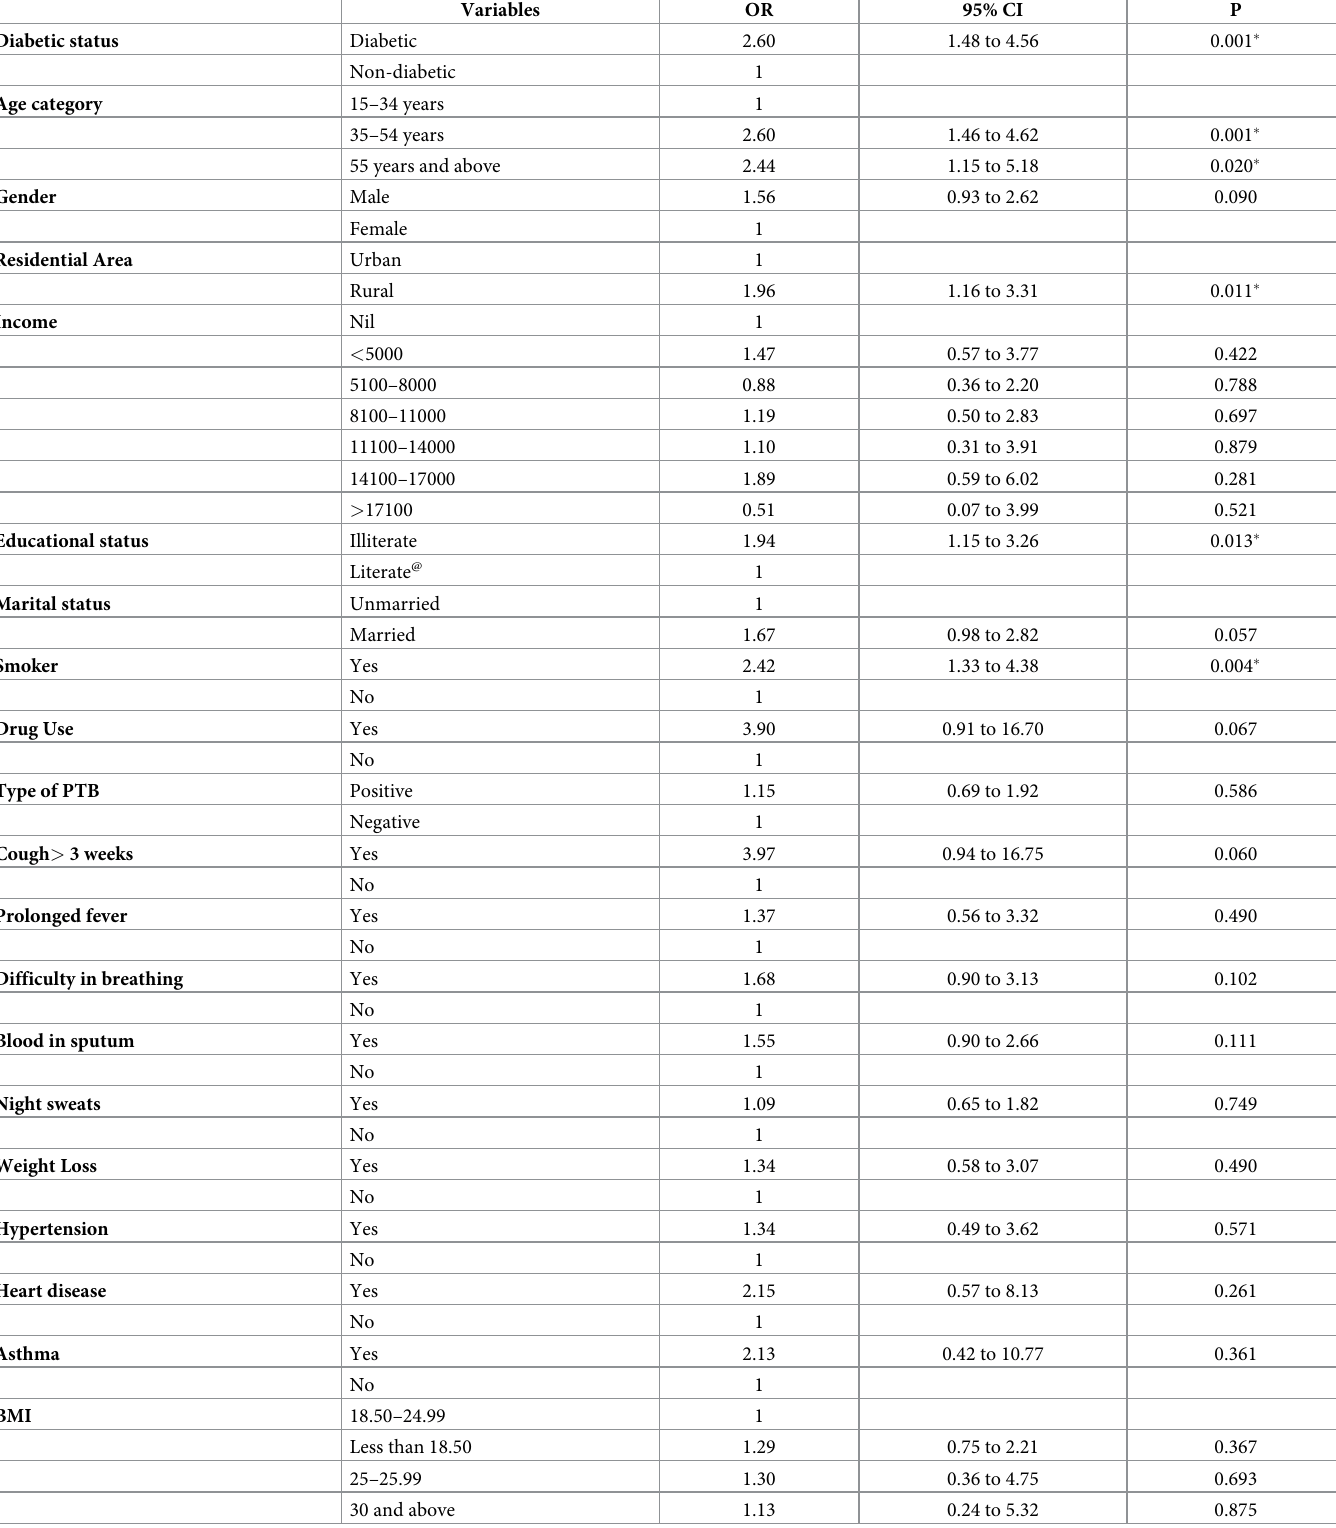
Table 2. Univariate analysis of favorable and unfavorable treatment outcome among 503 pulmonary tuberculosis patients and its